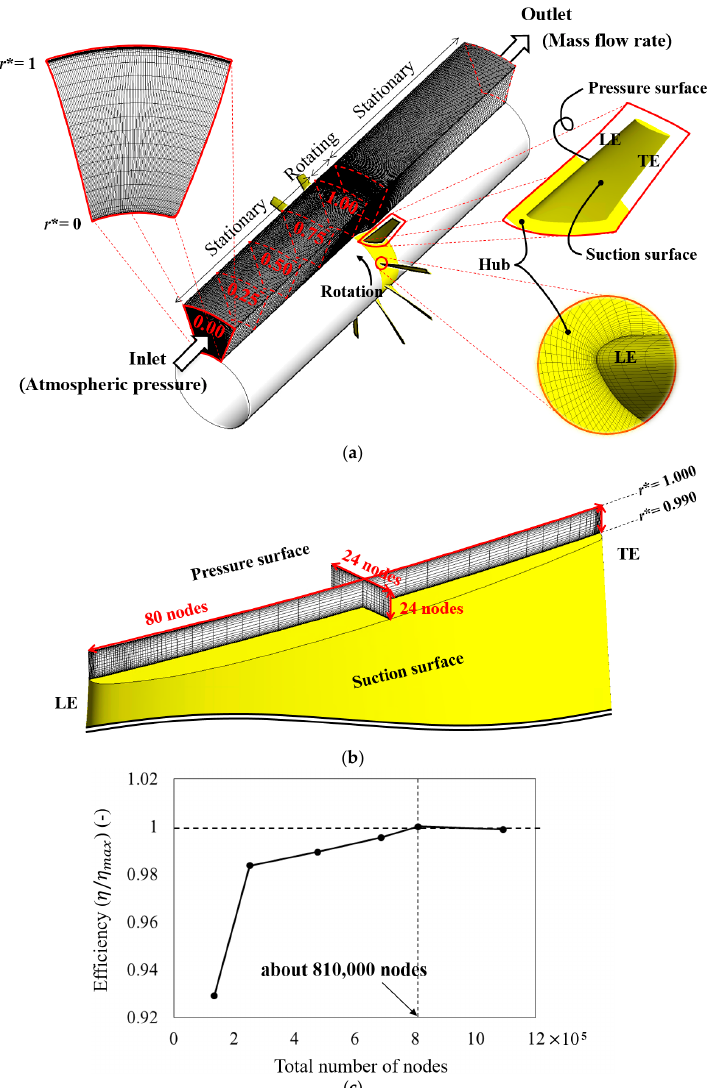
Figure 5. Computational domain and grid system: ( a ) flow passage; ( b ) tip clearance; ( c ) result of grid test.